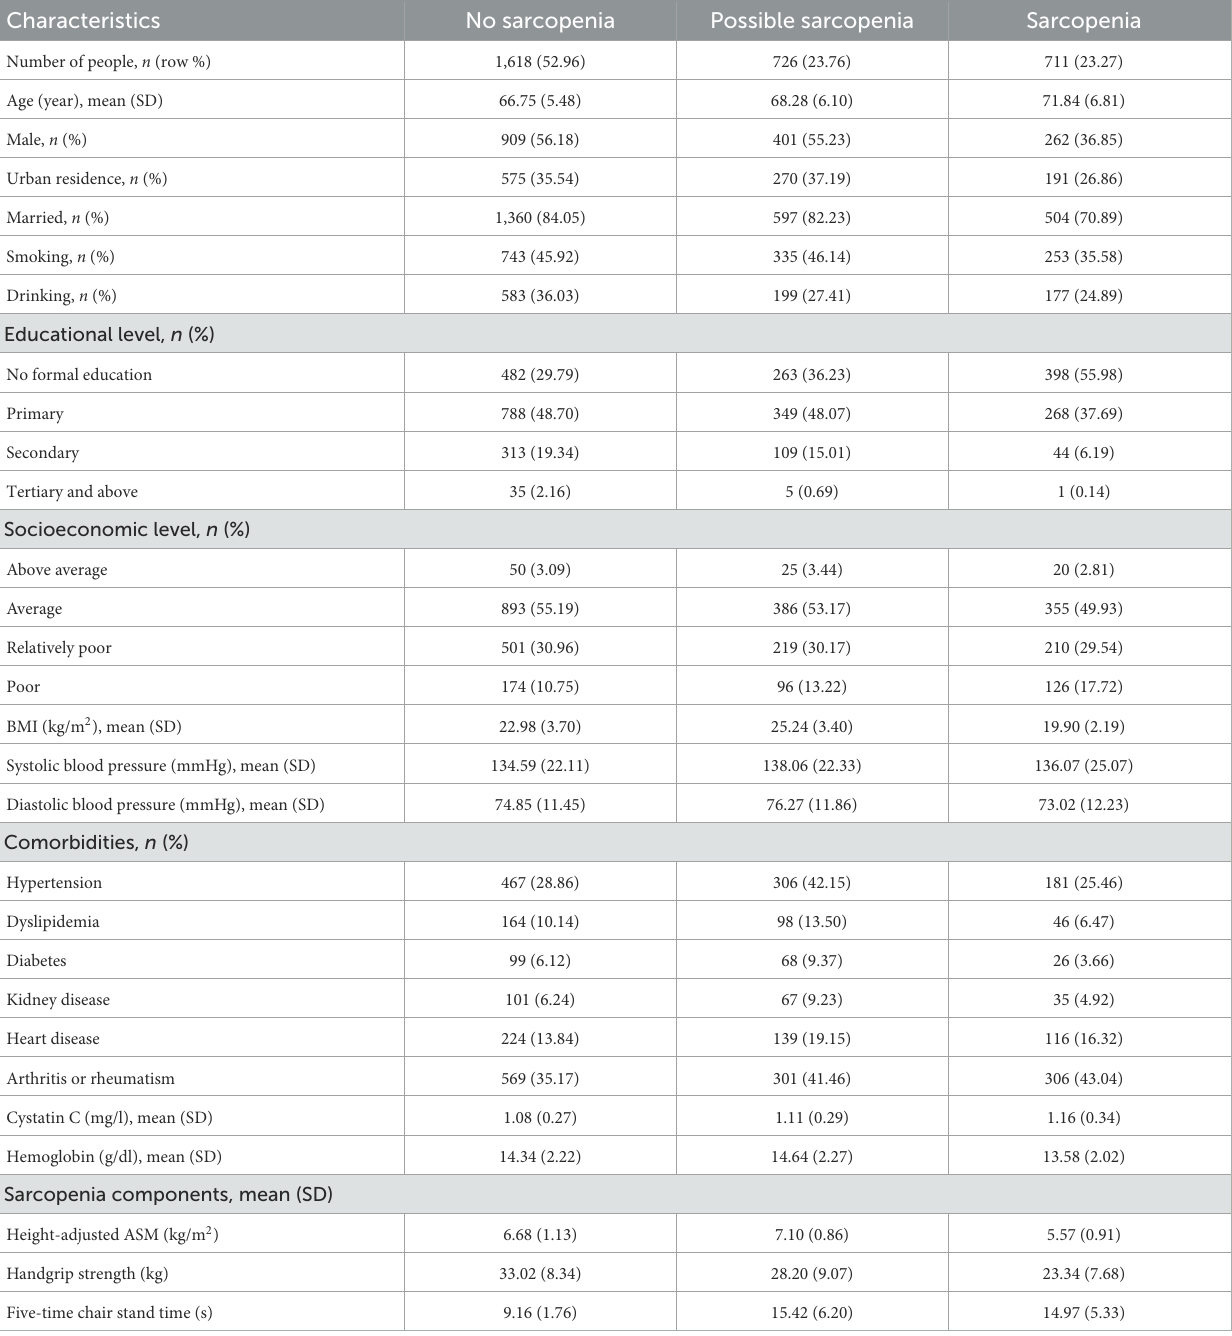
TABLE 1 Baseline characteristics of 3,055 CHARLS participants, stratified by their sarcopenia status in year 2011. Characteristics No sarcopenia Possible sarcopenia